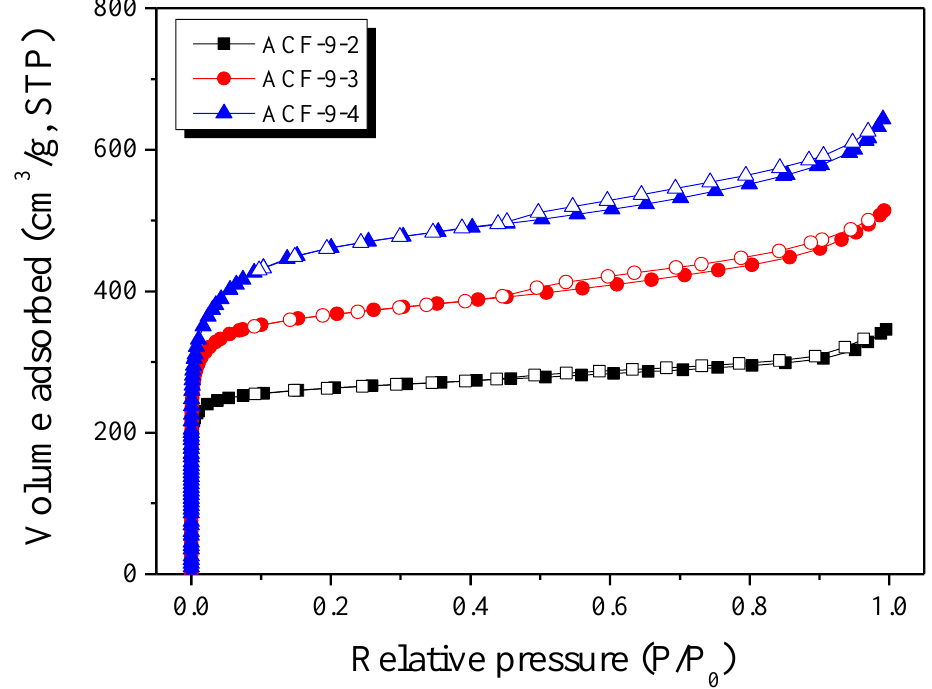
Figure 8. N 2 /77K adsorption/desorption isotherms of LLDPE-based activated carbon fibers as a function of activation time. Table 4. Pore characteristics of activated carbon fibers based on LLDPE manufactured with different activation